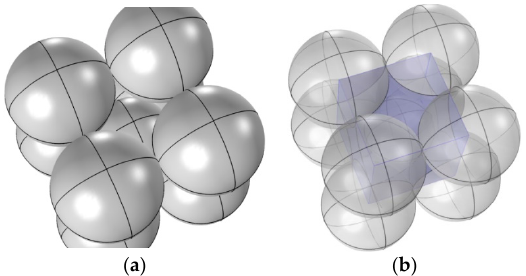
Figure 3. The microelement of the simplified three-dimensional physical model for the tight sandstone gas reservoirs. ( a ) A cube microelement in the physical model; ( b ) The blue cube is a percolation microelement.